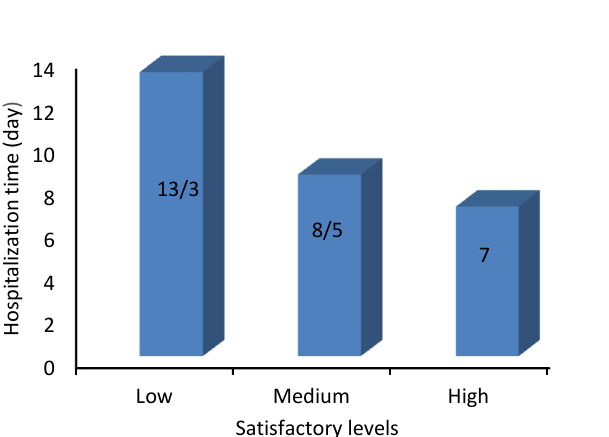
Fig. 4. The mean of hospitalization time effect on satisfaction